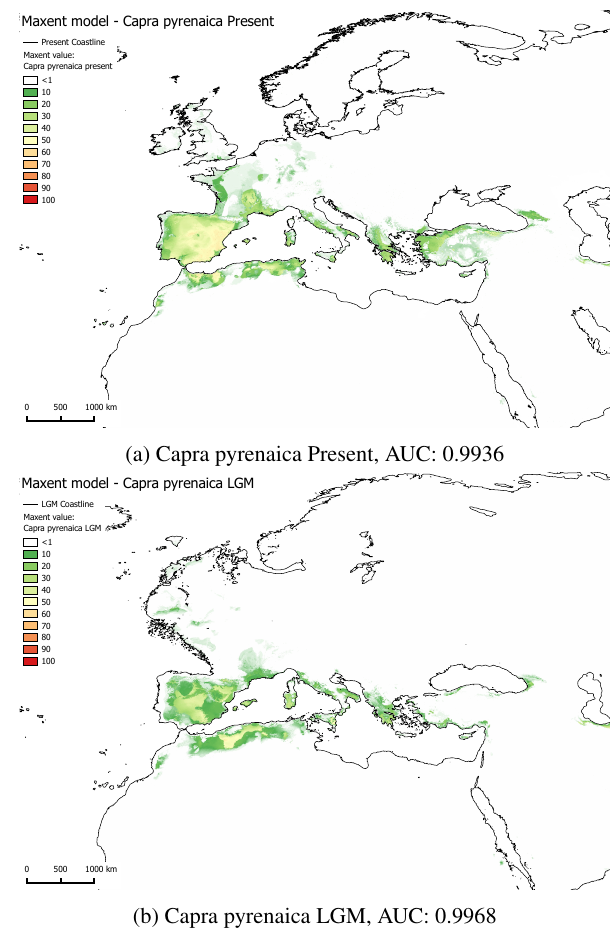
Figure 5: Maps showing modelling results for Capra pyrenaica with Maxent values